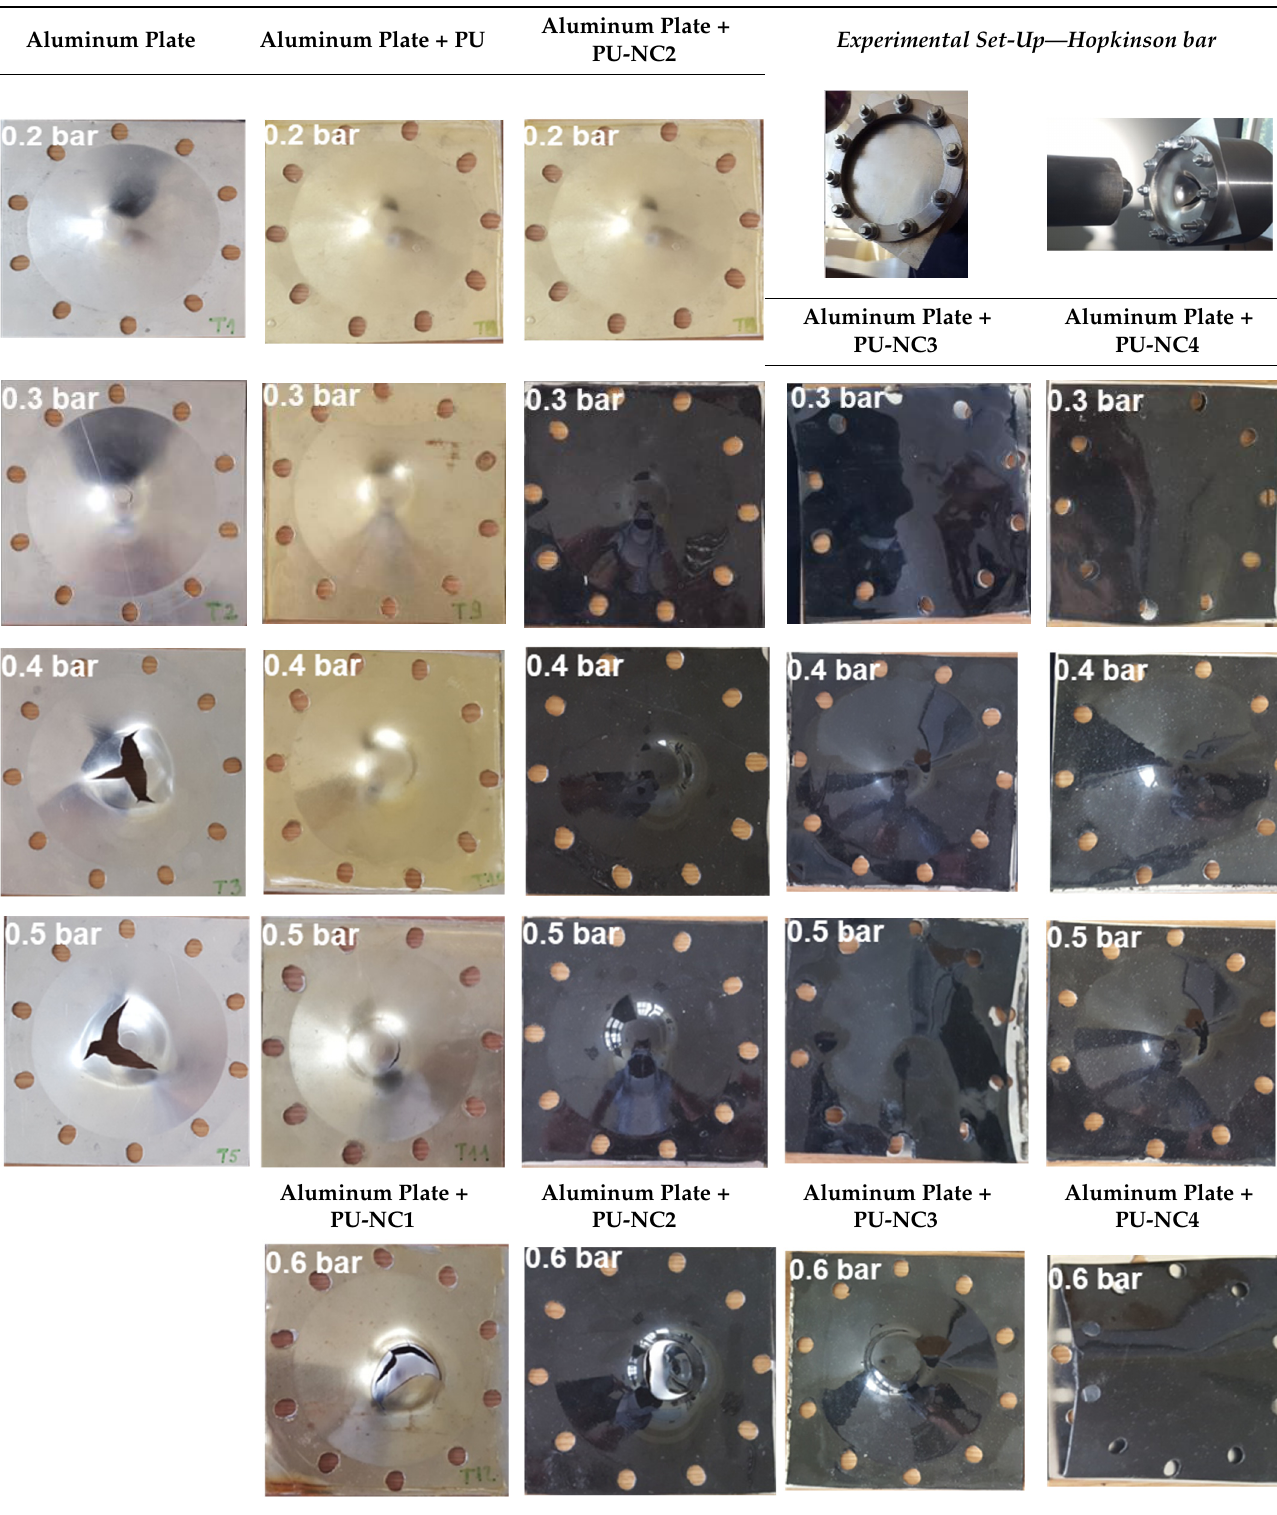
Table 7. Images of the tested specimens, captured after the impact tests with Hopkinson bar (pressure in bar and pattern of deformation).